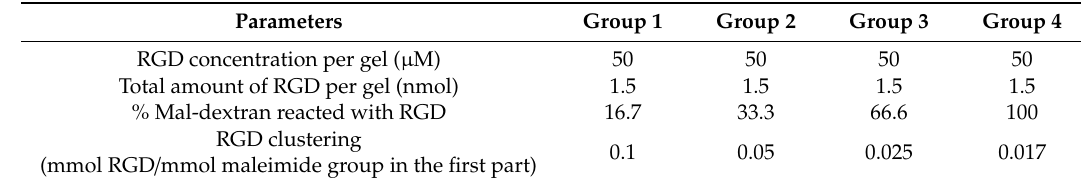
Table 1. Four di ff erent RGD distributions were performed for 3D dextran hydrogel. The levels of RGD clustering decreased from Group 1 to Group